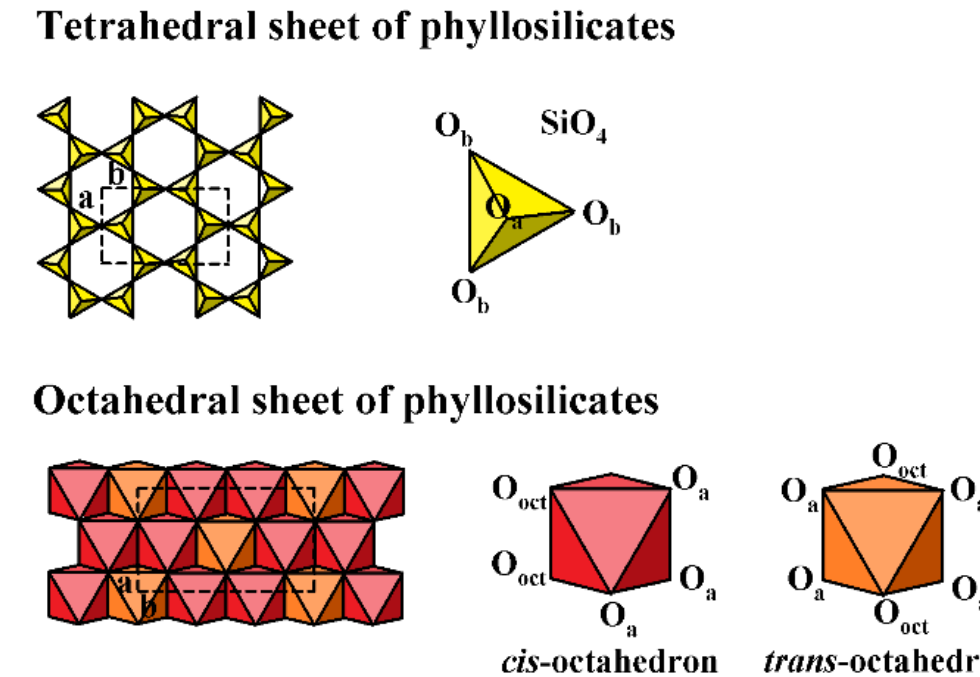
Figure 1. Typical tetrahedral sheet and octahedral sheet in the phyllosilicates.